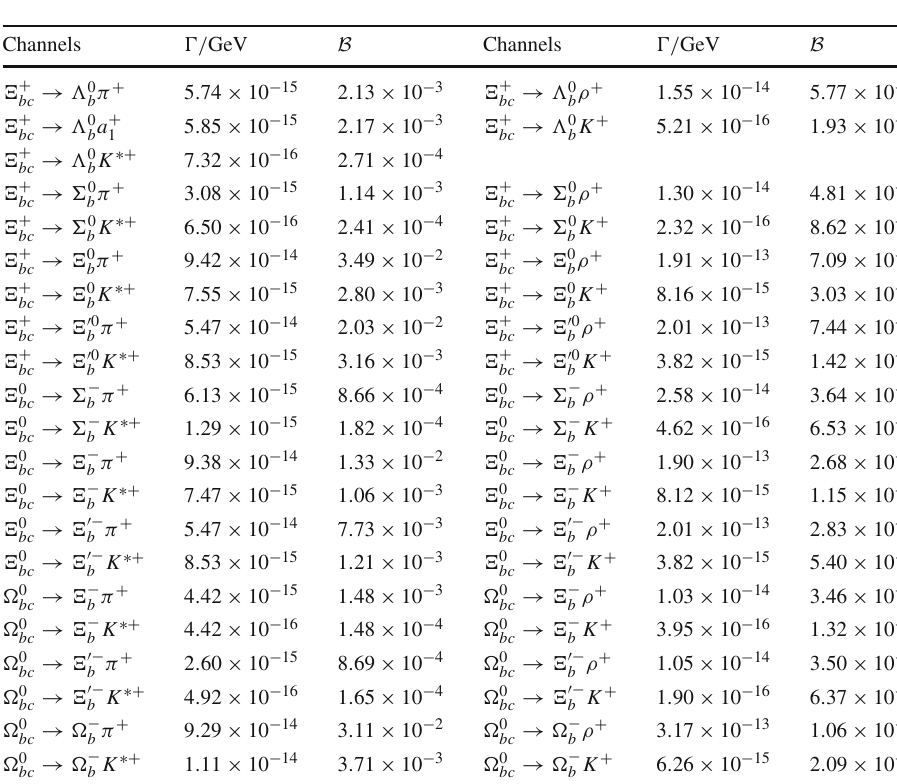
Table 26 Partial decay widths and branching ratios for nonleptonic charm decays of the bottom–charm baryons with axial vector bc